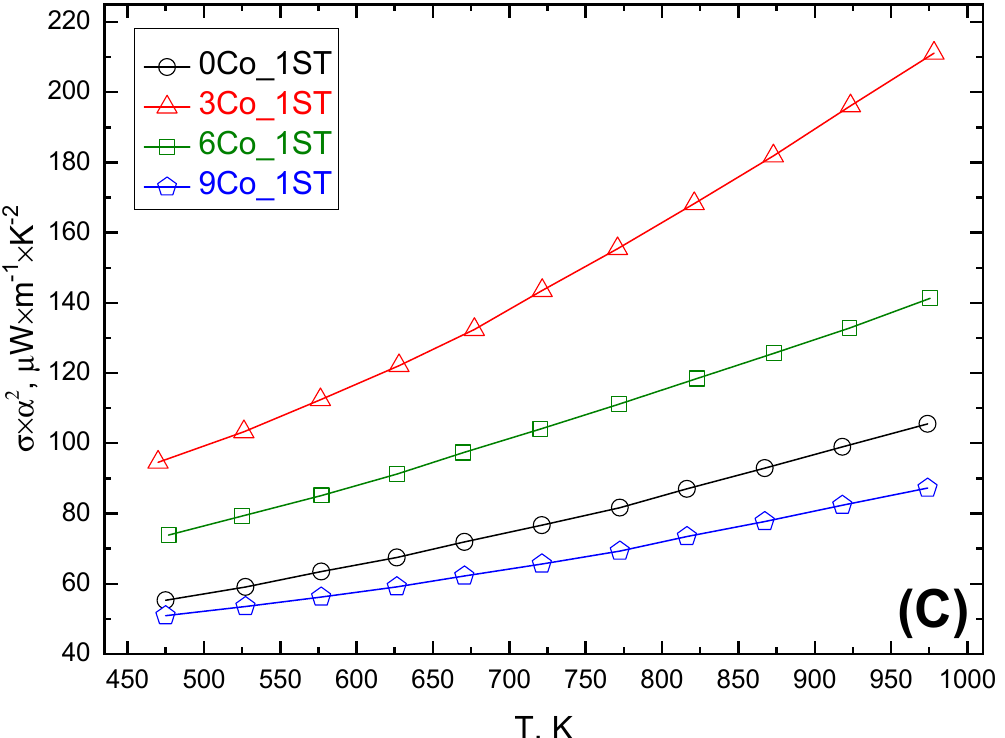
Figure 5. Electrical conductivity ( A ), Seebeck coefficient ( B ) and power factor ( C ) for 1ST sintered samples.